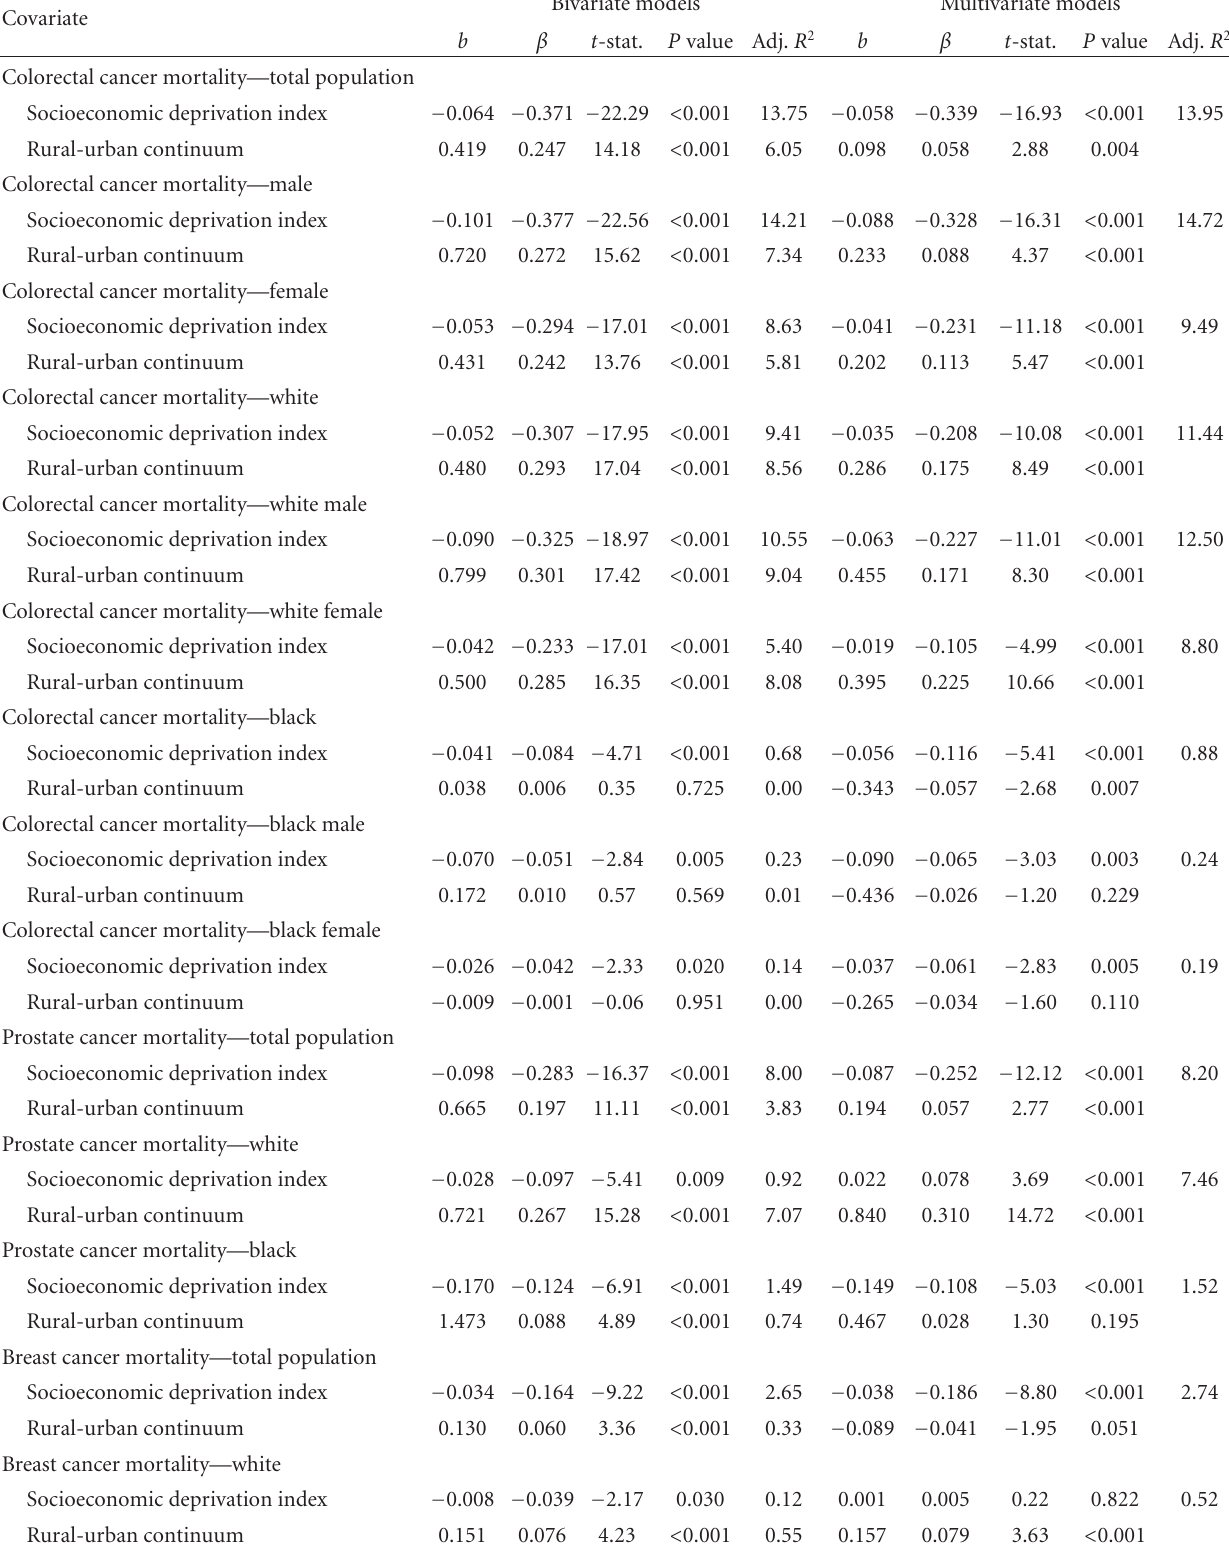
Table 7: Weighted least squares regression models 1 showing the relative impacts of the continuous socioeconomic deprivation index 2 and rural-urban continuum 3 on county-level age-adjusted mortality rates for colorectal, prostate, breast, and cervical cancers, United States, 2003–2007 ( N =